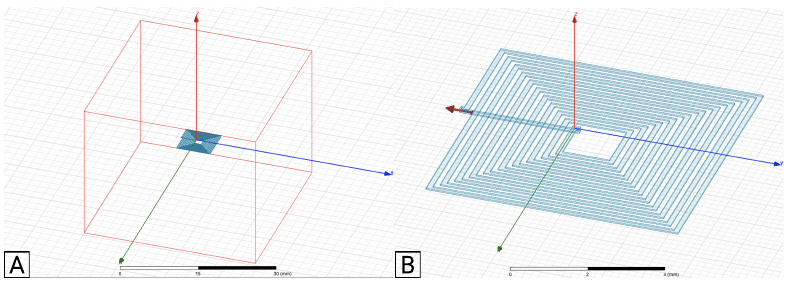
Figure 7. ( A ): Ansys project with 1-layer coil and air box. ( B ): Current applied into the coil.